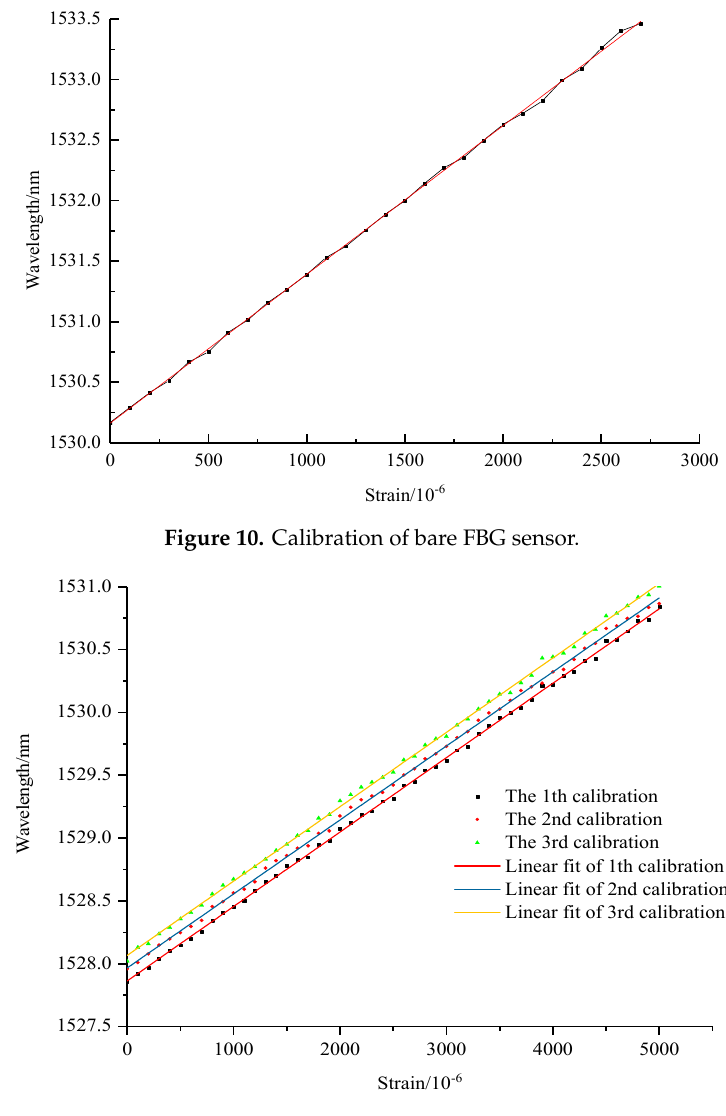
Figure 11. Calibration of 2 times range sensor.